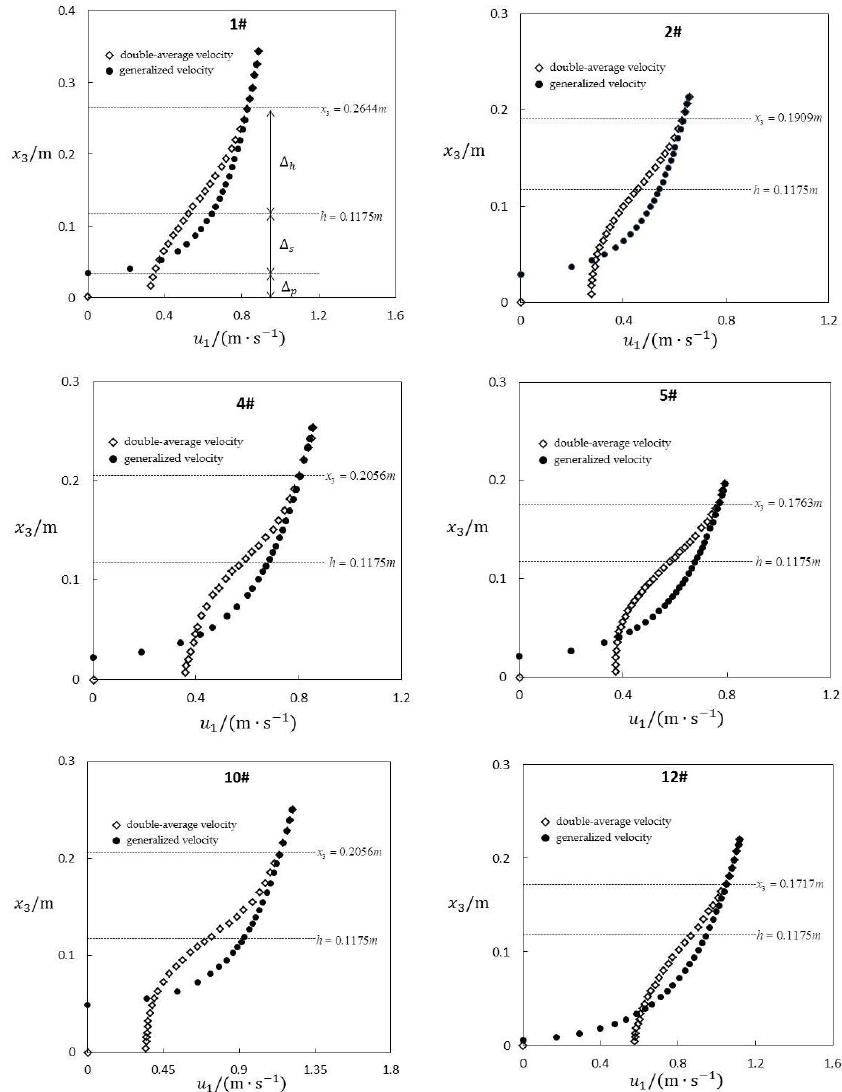
Figure 4. Comparison of the double-mean velocity (cid:104) u 1 (cid:105) and generalized velocity u 1 . (The upper dotted line is the depth of influence, the middle dotted line is the height of vegetation and the lower dotted line is the top of the virtual canal.).